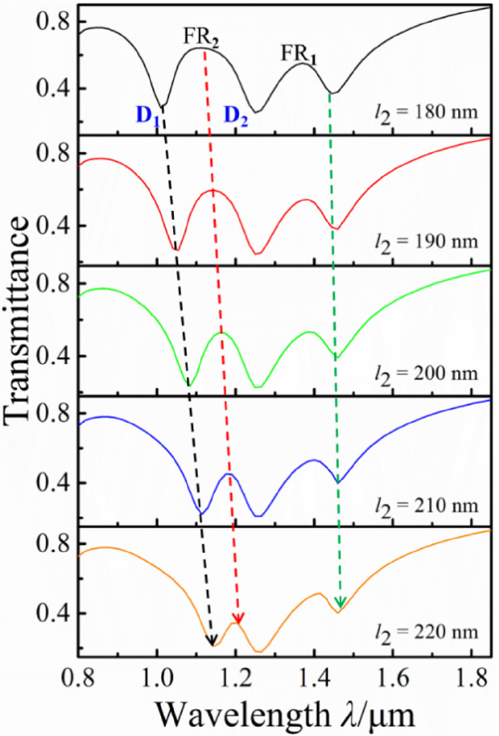
Figure 5. Transmission spectra with different horizontal bottom nanorod lengths l 2 .